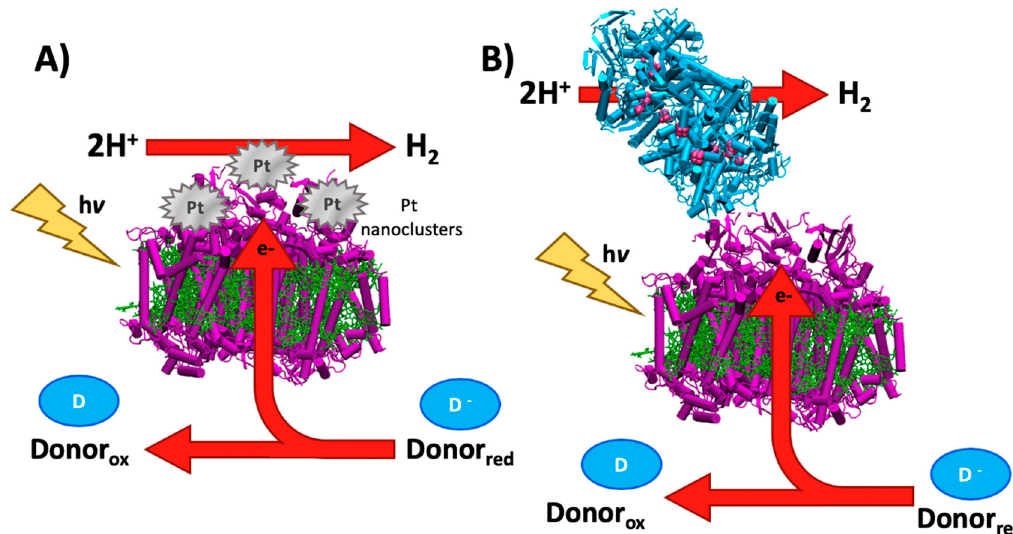
Figure 4. Comparison of methods for hydrogen evolution by reaction centers. Two common methods for reaction center modification for hydrogen evolution are platinization, shown in ( A ), and coupling to a hydrogenase enzyme, shown in ( B ). Shown in purple in both panels is the protein backbone of PSI, with chlorophyll antenna shown in green. A [Fe-Fe] hydrogenase enzyme is shown in 4B in light blue, with metal clusters shown in pink. The flow of electrons from the donor molecule through the reaction center are shown in red arrows. Figure adapted from [73].